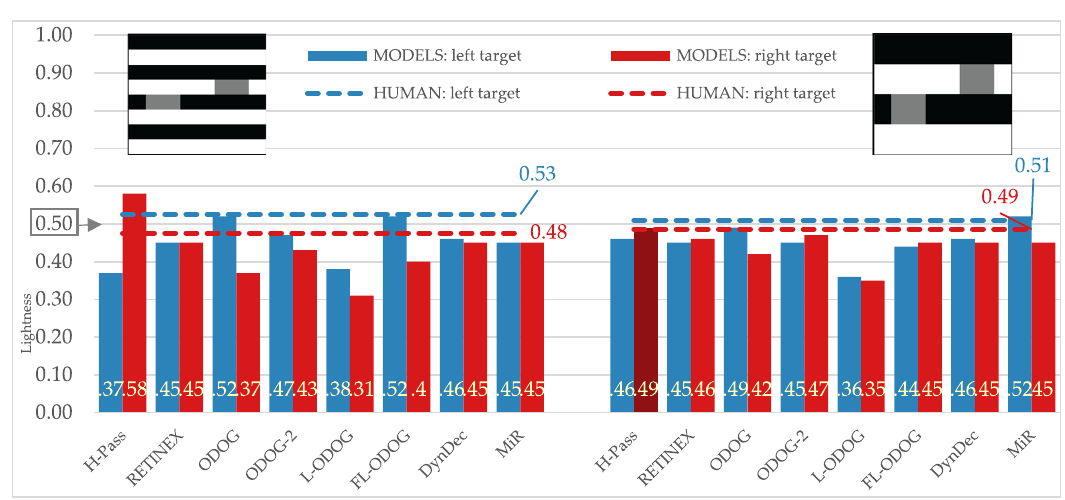
Figure 7. Empirical and model results for standard and large stripes variation of White’s illusions. The target lightness value is marked at 0.5 on the Y